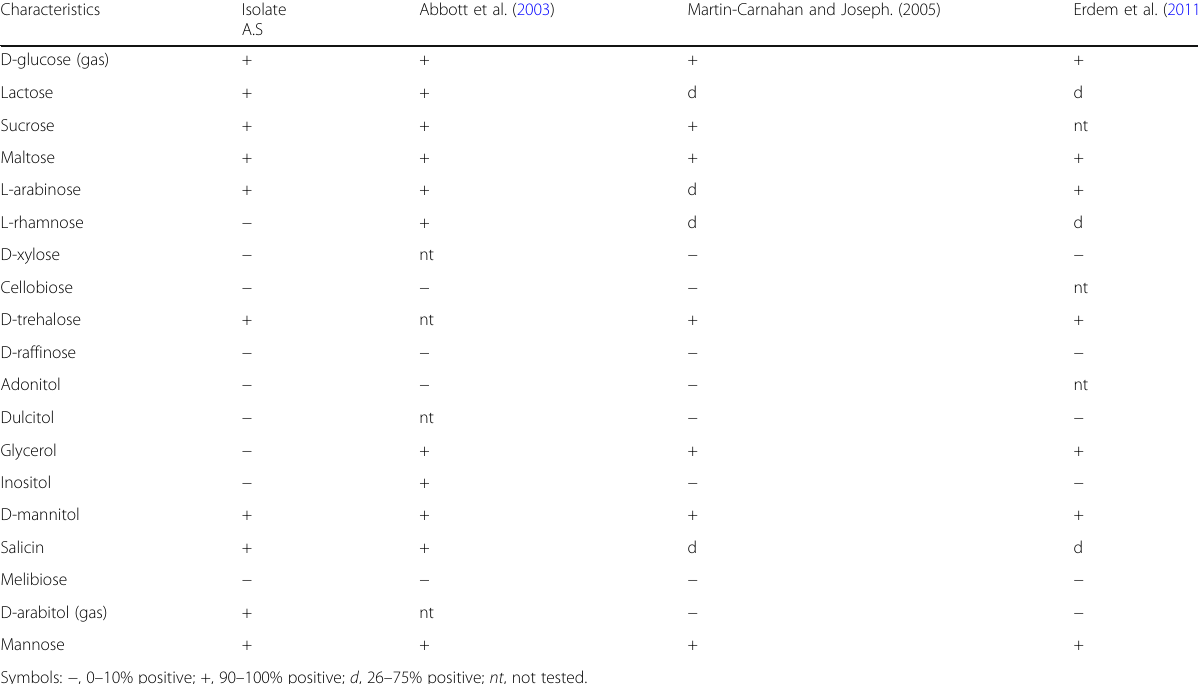
Table 3 Acid production from saccharides by isolate A.S compared to those reported for Aeromonas hydrophila by Abbott et al. (2003), Martin-Carnahan and Joseph. (2005) and Erdem et al. 2011)